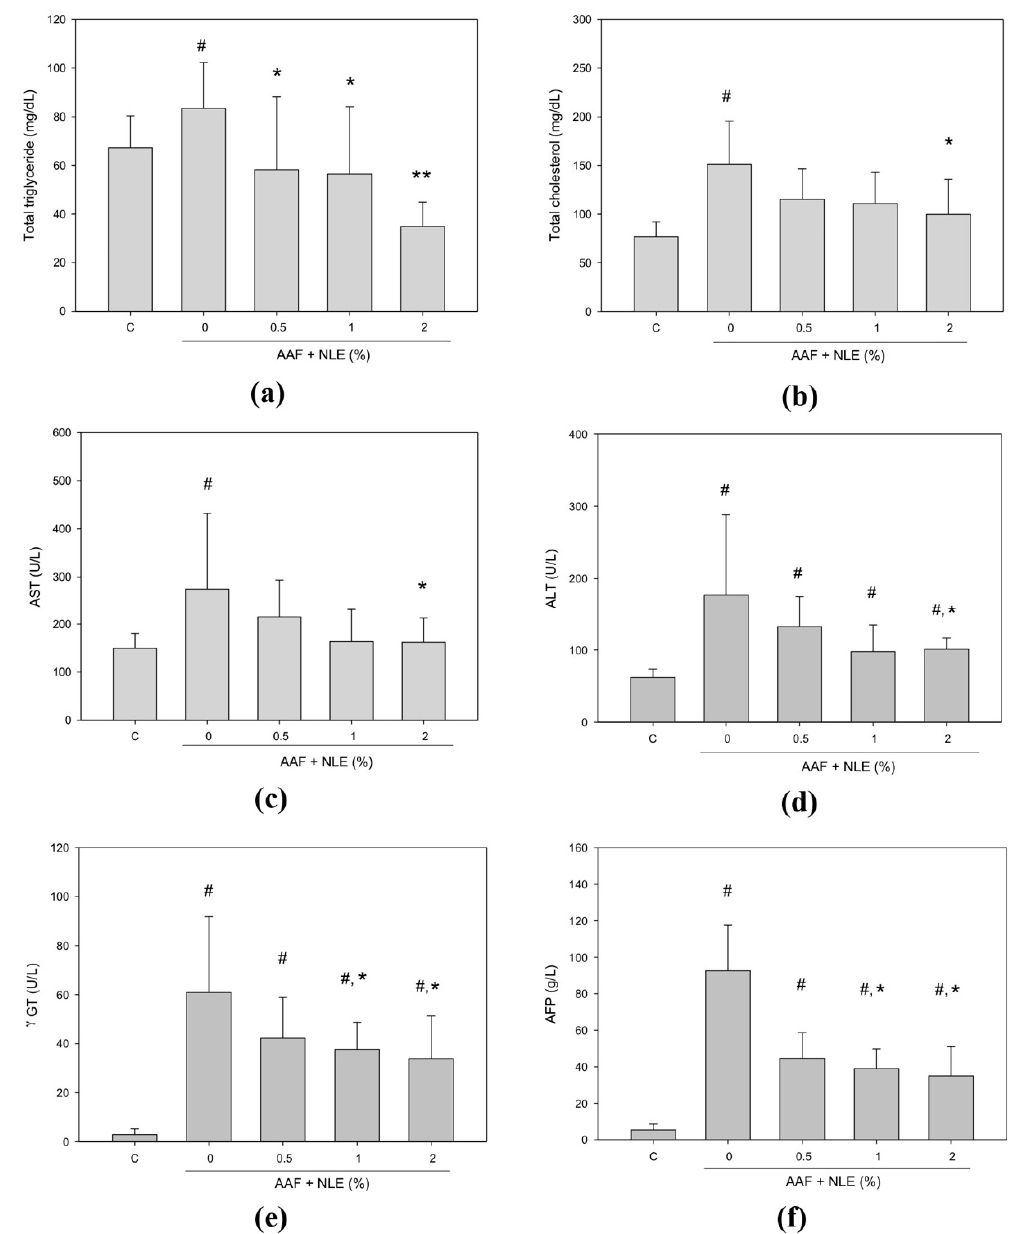
Figure 3. Effect of NLE supplementation on the serum biomarkers of hepatic injury and hepatocellular carcinoma in AAF-induced rats. The biomarkers quantitated were as follows: ( a ) total triglyceride level, ( b ) total cholesterol level, ( c ) aspartate aminotransferase (AST) activity, ( d ) alanine aminotransferase (ALT) activity, ( e ) gamma-glutamyl transferase ( γ GT) activity, and ( f ) alpha-fetoprotein (AFP) level in plasma from AAF-induced rats. C, a normal diet; AAF, a normal diet containing AAF; AAF + NLE 0.5%, a normal diet containing AAF with 0.5% NLE; AAF + NLE 1%, a normal diet containing AAF with 1% NLE; and AAF + NLE 2%, a normal diet containing AAF with 2% NLE. Data are shown as means ± SDs; Results were statistically analyzed with ANOVA and significantly di ff erent was set as p < 0.05 according to Duncan’s multiple range test. # p < 0.05, compared with the control group and * p < 0.05, and ** p < 0.01, compared with the AAF group.